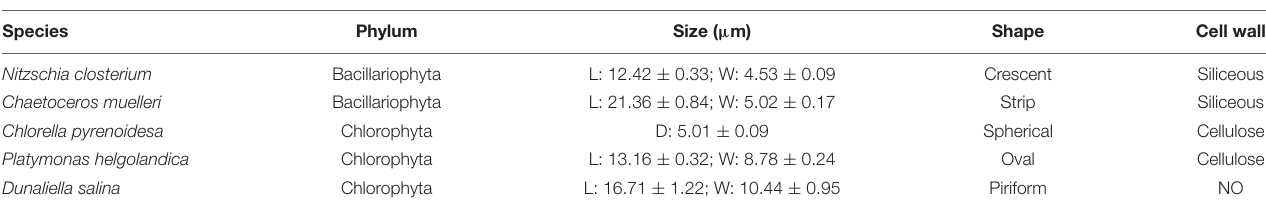
FIGURE 1 | Main developmental stages of Mulinia lateralis , including larvae, juvenile, spat, and adult. Scale bar of 300 µ m is used for the larvae and juvenile, while scale bar of 3 mm is used for spat and adult. TABLE 1 | Characteristic of microalgae species used in feeding